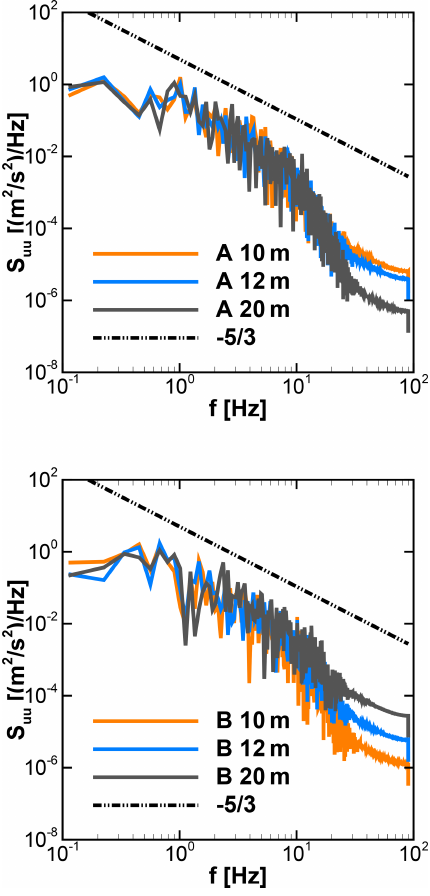
Figure 14. Power spectral density S uu of u component of the ve- locity at wind turbine positions. Table 4. Power coefficients of wind turbine at different heights over A and B. Height over Power coefficient Power